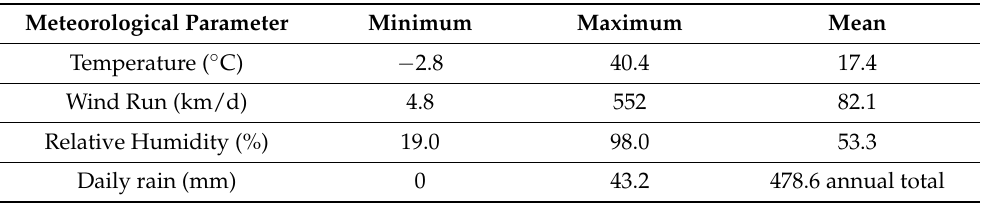
Table 1. Overview of the meteorological parameter statistics used in the model run (January– December 2015). Meteorological Parameter